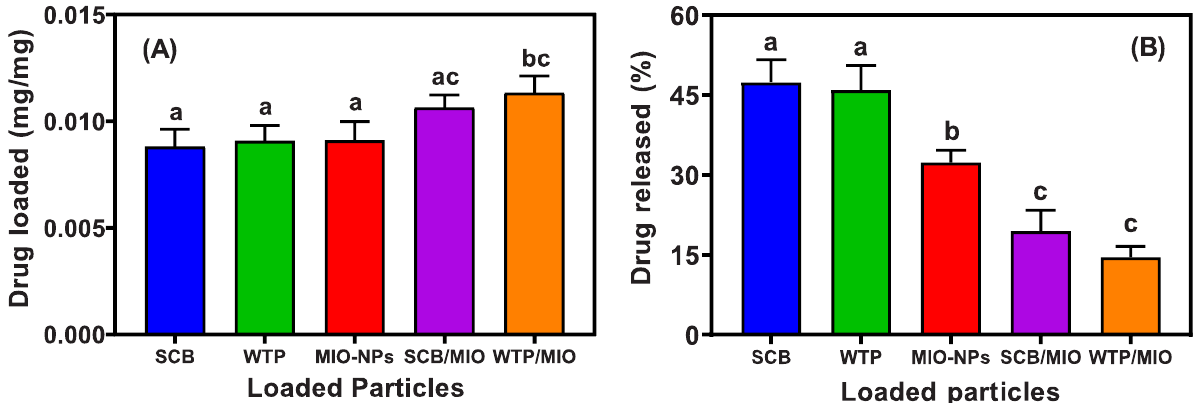
Figure 12. ( A ) Amount of drug-loading and ( B ) drug-releasing efficiency of cellulose (SCB and WTP), MIO-NPs, SCB/MIO-NCPs, and WTP/MIO-NCPs. Similar letters above bars indicate no significant differences at p - value ≤ 0.05.